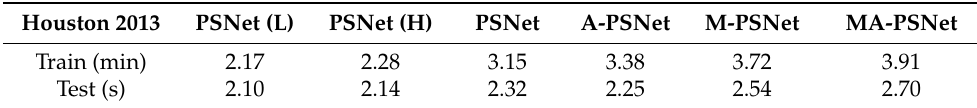
Table 7. The computation time of different models on the Trento